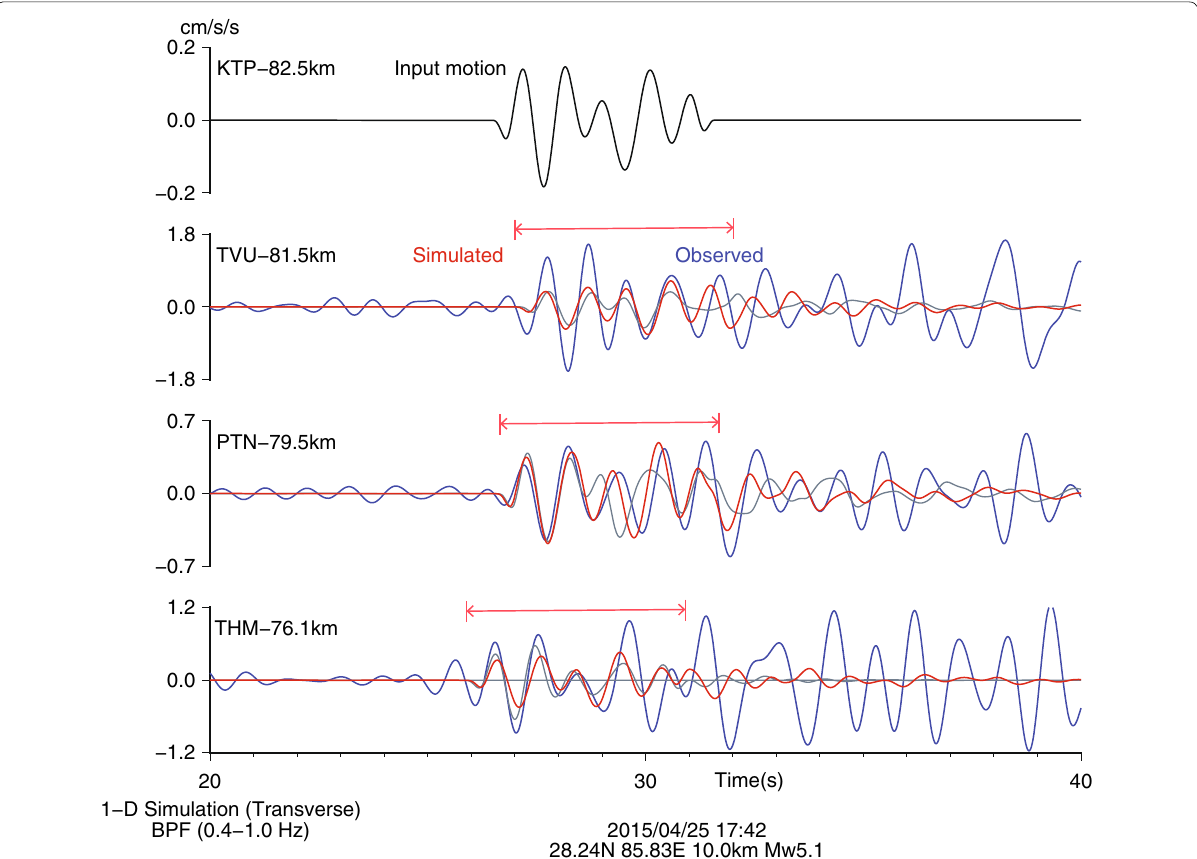
Fig. 9 Simulation of the Mw5.1 earthquake using the adjusted velocity model. The observed amplification at TVU is larger than the simulated waveform. The gray waveform is the result from the Propagator Matrix method using the initial velocity model. Waveform matching was conducted using trial and error for time windows indicated by the red